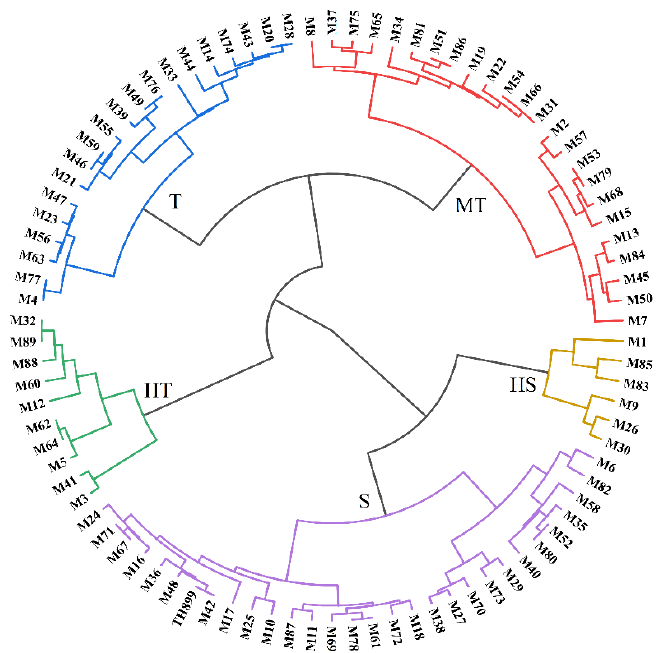
Figure 2. Hierarchical cluster analysis based on the germination percentage. Euclidean distance and Ward’s algorithm were used to evaluate the saline–alkaline tolerance of 89 mutant lines and the parent TH899. Green indicates highly tolerant (HT) lines; blue indicates tolerant (T) lines; red indicates moderately tolerant (MT) lines; purple indicates sensitive (S) lines; and yellow indicates highly sensitive (HS) lines.